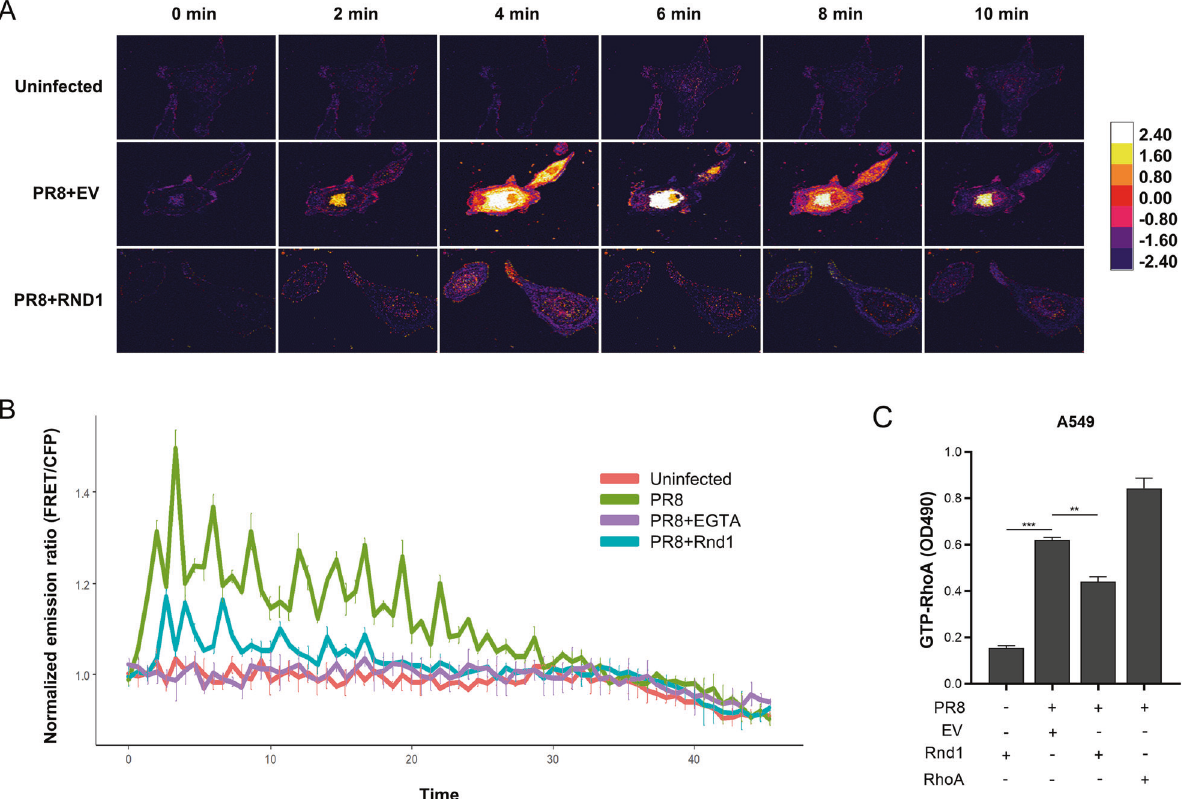
Fig. 5 Rnd1 disrupts cytoplasmic calcium oscillations. A Plasmid expressing Rnd1 or EV was transfected into A549 cells along with YC3.6 plasmids. Microscopic images were recorded for CFP (480 nm) and YFP (530 nm) at intervals of 60 s. Images were analysed by FRETanalyzer plugin in ImageJ software. B As an indicator of intracellular calcium levels, FRET/CFP lvel was plotted against time. C A549 cells were transfected either with plasmid expressing Rnd1, RhoA, or EV followed by infection with PR8. Rho A activation was analysed using